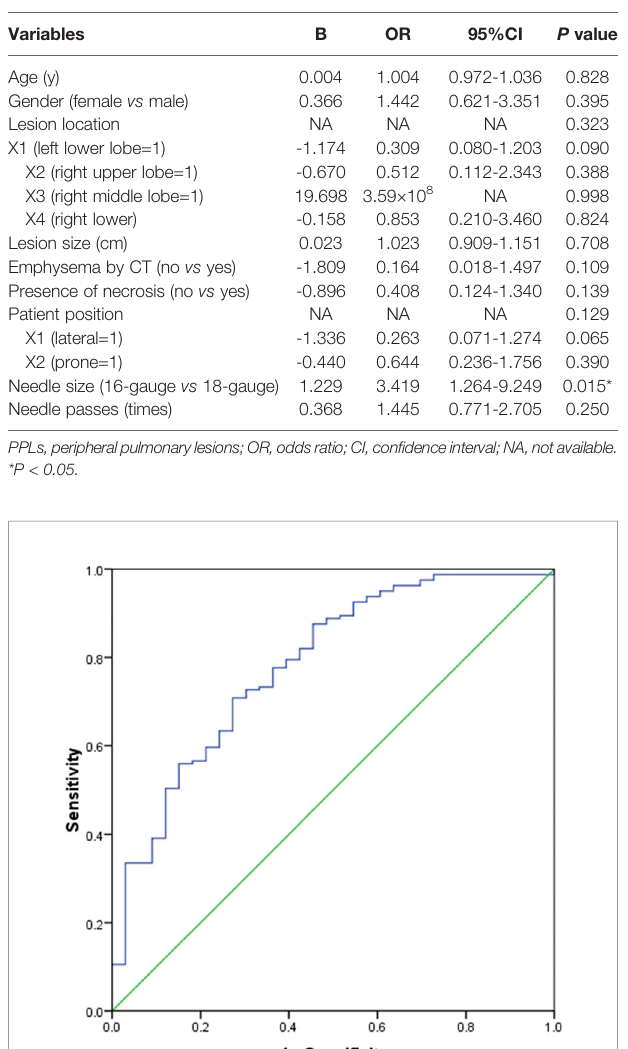
pneumothorax group and non-pneumothorax group (all P >0.05) TABLE 4 | Multivariate logistic regression analysis of in fl uence factors for sample